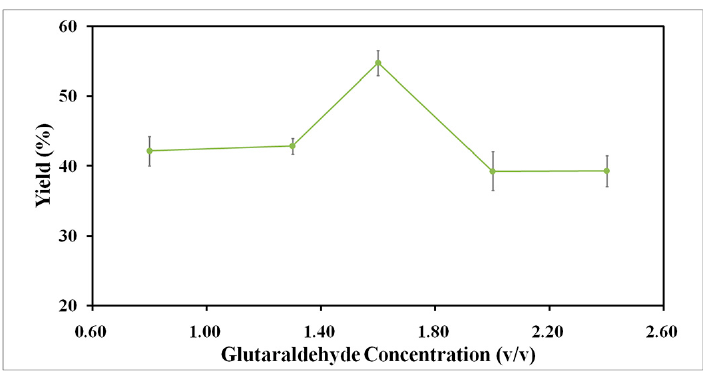
Figure 7. Effect of glutaraldehyde concentration on the activities of magnetic RML CLEAs.